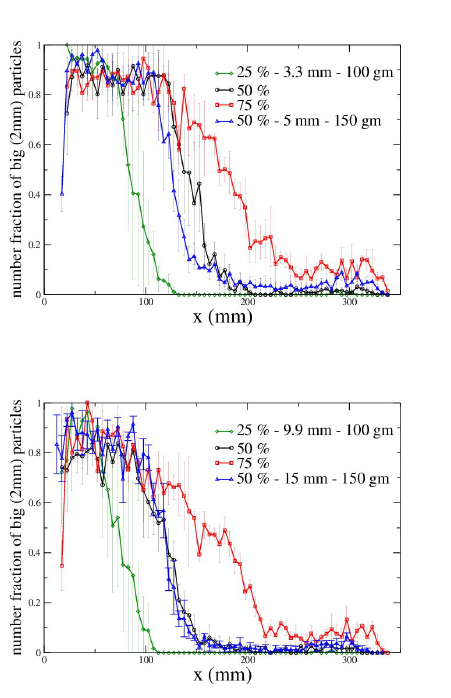
Figure 8. Comparison of number fraction of big particles (2mm) vs component x (mm) for surface layer (left) & second layer from top (right). Height of divider from bottom (h): 22 cm.